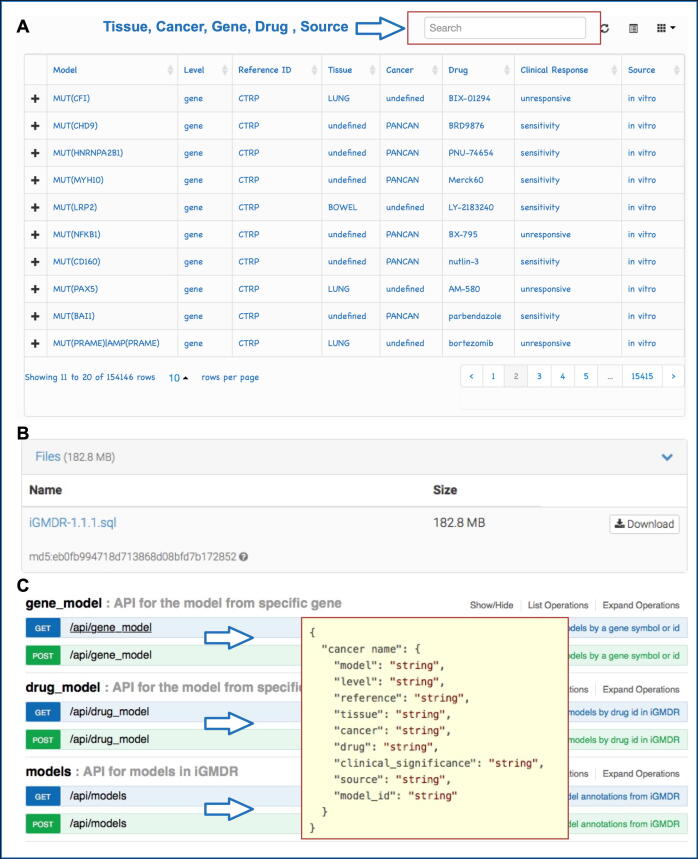
Exploring models in iGMDR. A. Model exploration by using a search box with different keywords. B. Downloading all tables of the database from zenodo.org for exploring the models. C. API calls return a json object for exploring the models.